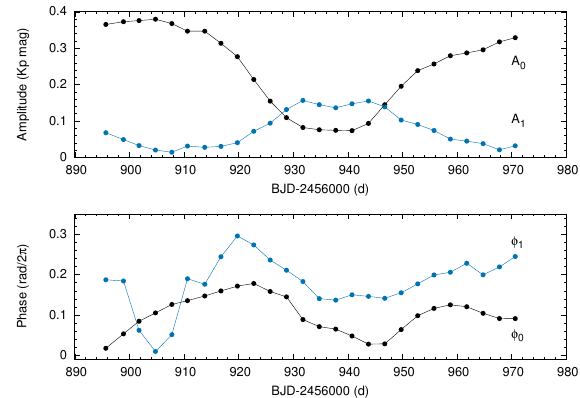
Figure 3: The temporal variation of the amplitudes and phases of the di ff erent the fundamental mode (black) and the first-overtone mode (blue) calculated with the Period04 software using 3 day